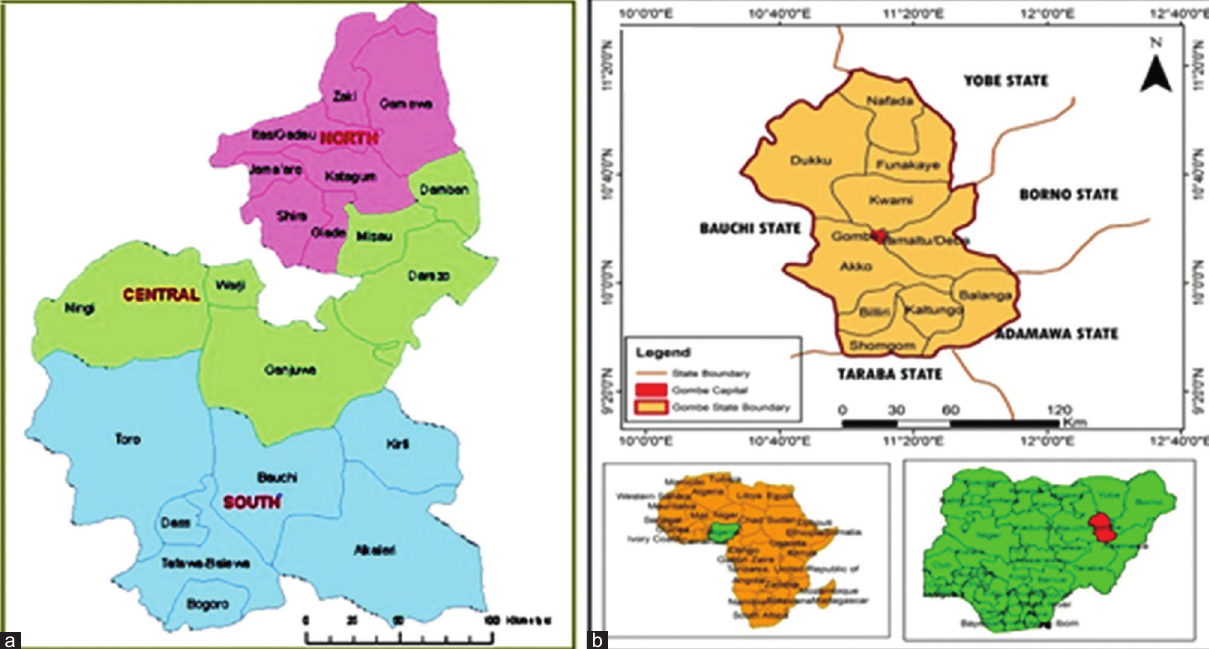
a Figure-1: (a) A map showing the study area in Bauchi State, northeastern, Nigeria and (b) a map showing the study area in Gombe State, northeastern, Nigeria.